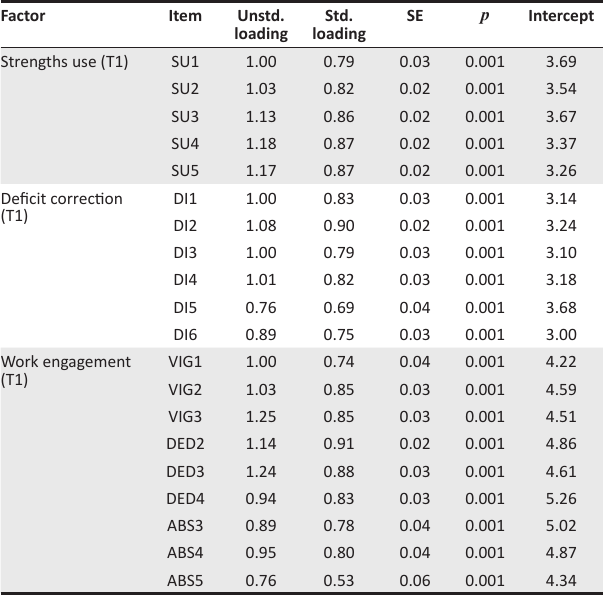
Std. SE p Intercept loading loading